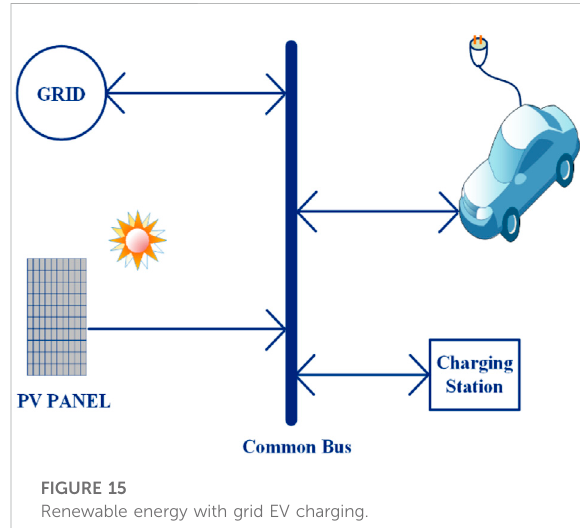
FIGURE 15 Renewable energy with grid EV